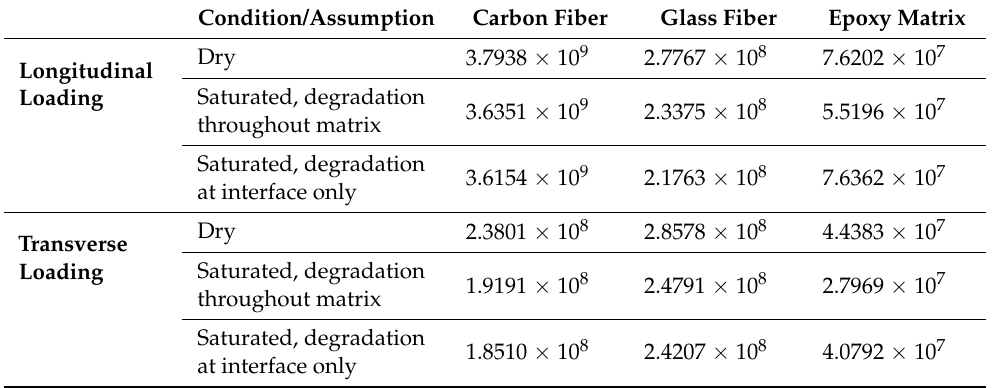
Table 8. Maximum Von Mises stress (Pa) occurring in each constituent material at the loading of ultimate failure under various loading, conditions, and